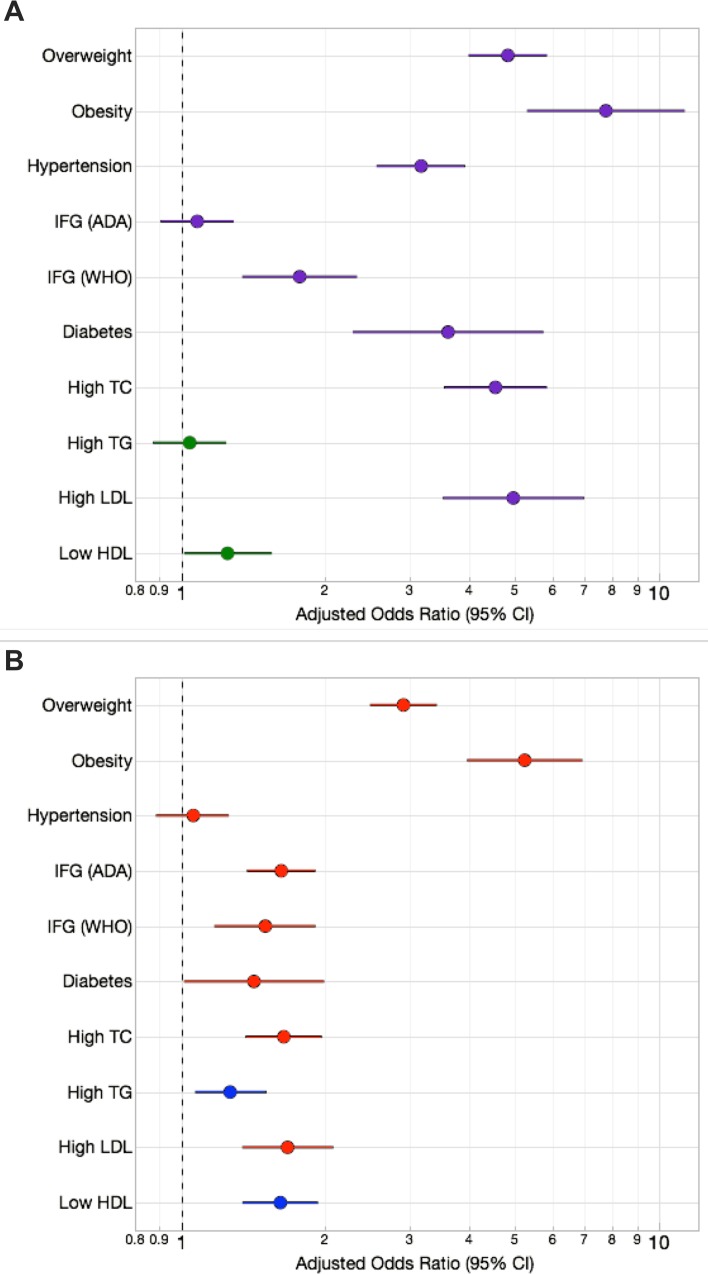
Effect sizes of urban/rural environment and sex on dichotomous cardiovascular risk factors in Brong Ahafo, Ghana.(A) The increased odds of each outcome (with 95% confidence intervals) are depicted for the group with the higher odds; purple for higher urban odds and green for higher rural odds. Data were adjusted for age and sex. (B) The increased odds of each outcome (with 95% confidence intervals) are depicted for the group with the higher odds (female: red; male: blue). Data were adjusted for age and environment. Abbreviations as described in methods.